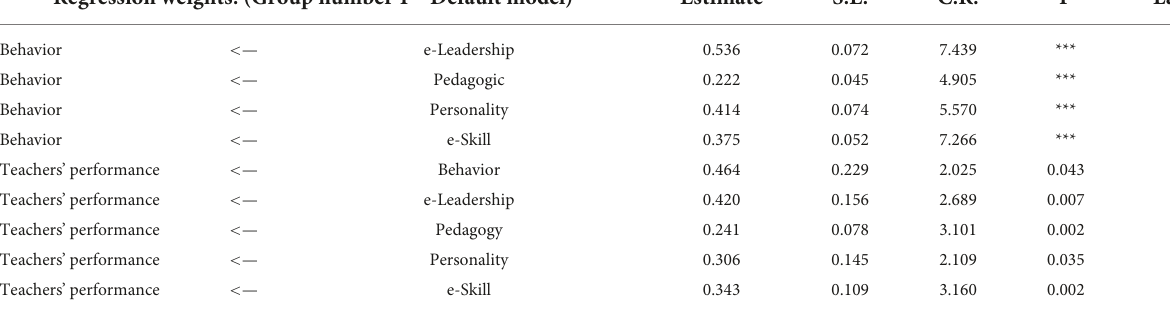
TABLE 13 The effect of the independent variable on the dependent variable. Regression weights: (Group number 1—Default